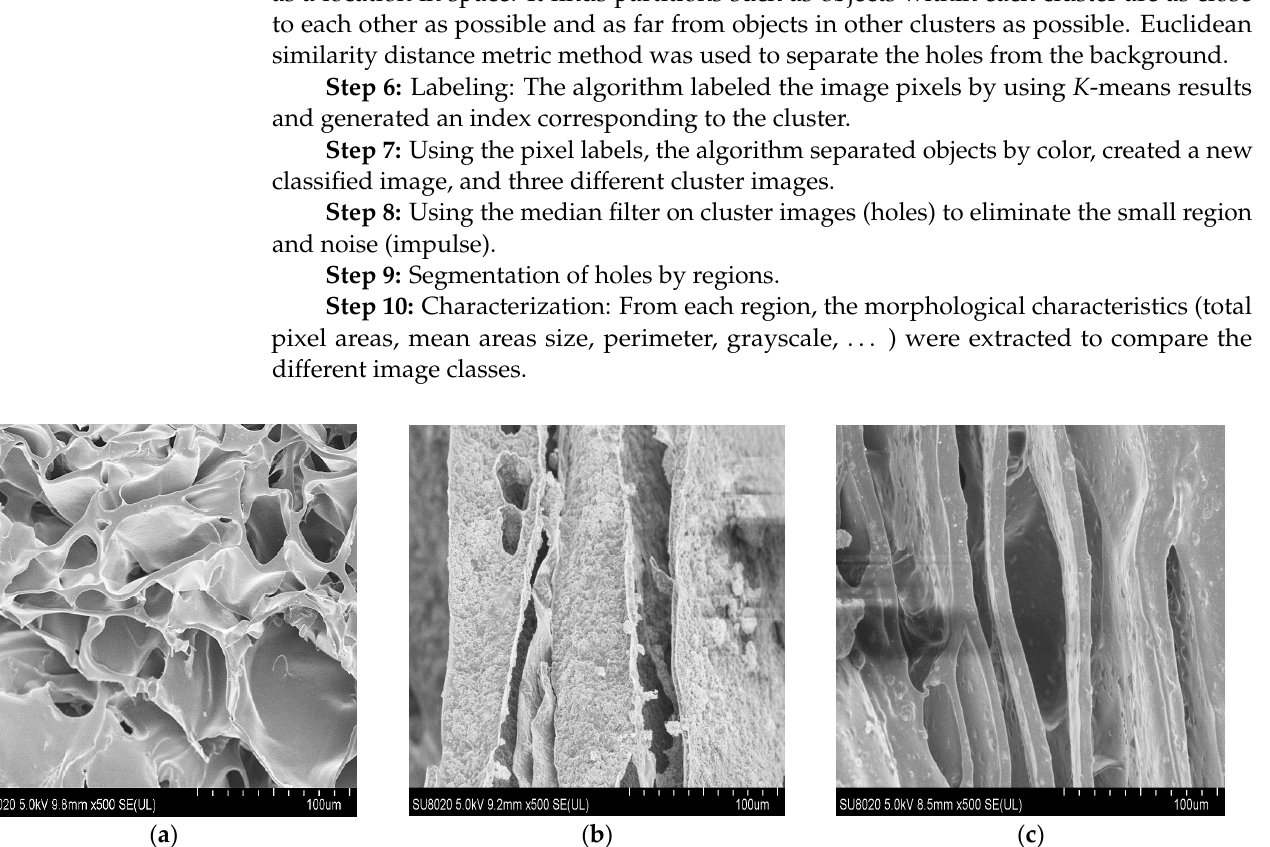
Figure 1. Scanning electron microscopy (SEM) images surfaces; Chitosan film ( a ), Chitosan/Silica Nanoparticle film ( b ), and Chitosan/Silica Nanoparticle/N film ( c ).